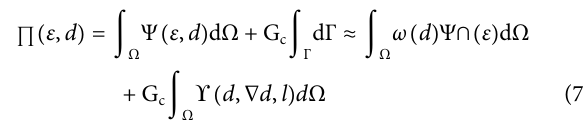
Frontiers in Materials |